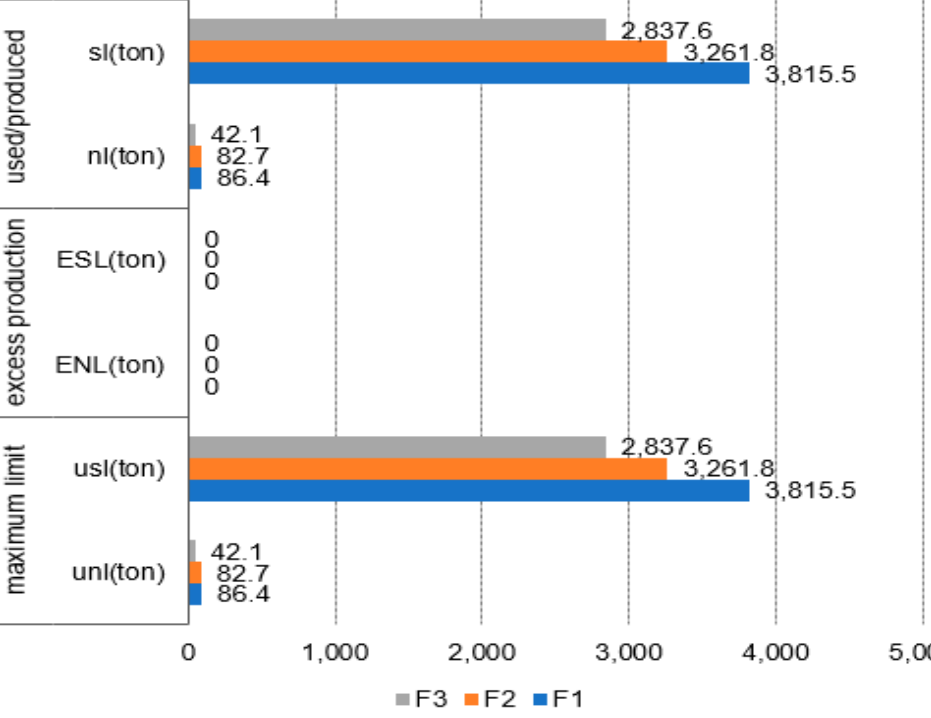
Figure 19. Environmental induced problems from allocated alternative crop successions per farm per year(ton/farm/year) (Farm 1, 2, and 3).